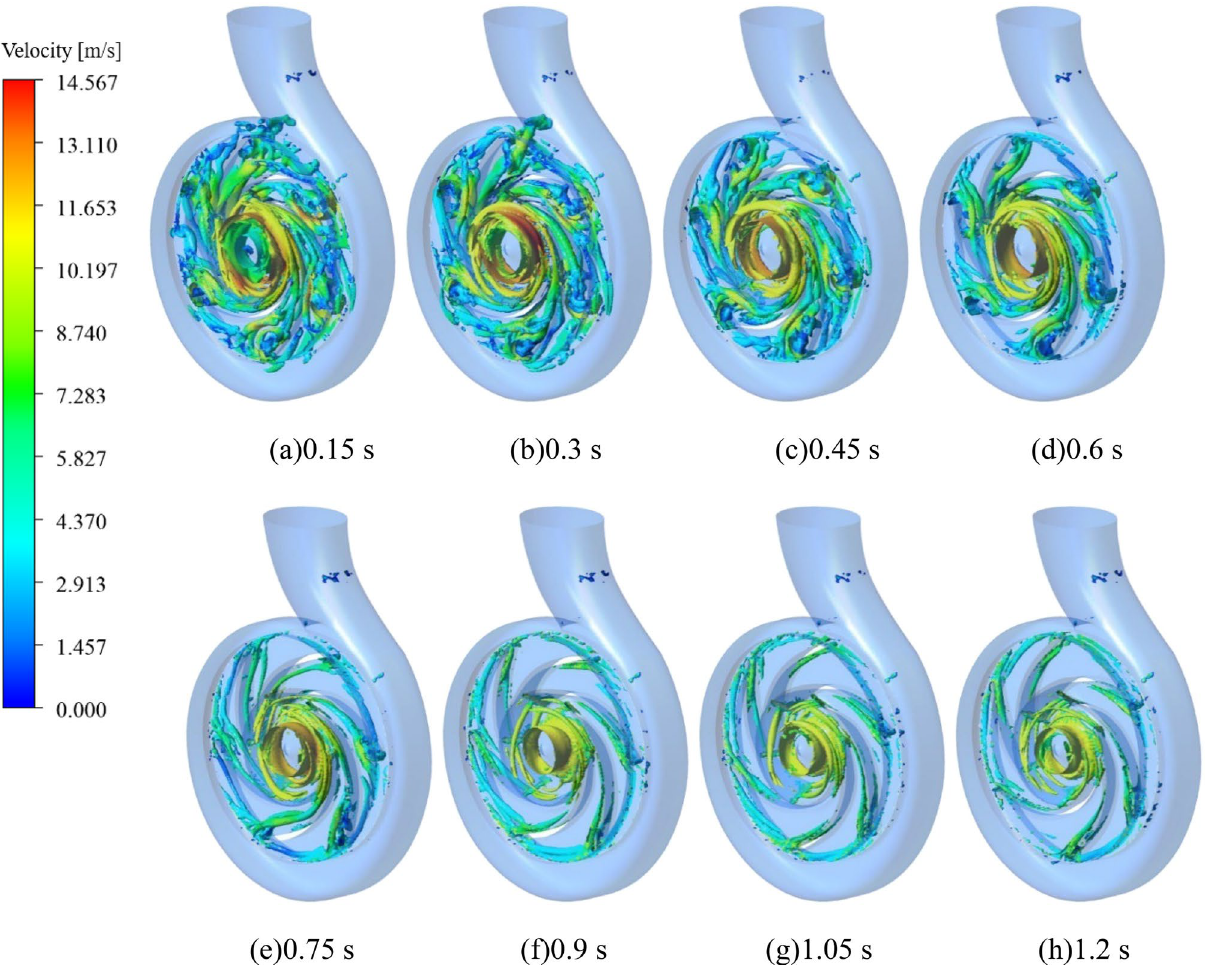
Figure 20. Evolution of the morphology of the vortex inside the pump as turbine during medium-speed start-up